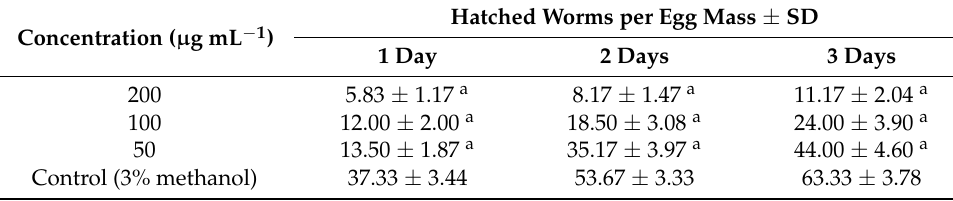
Table 4. Inhibition of Egg hatching of M. incognita by compound 1